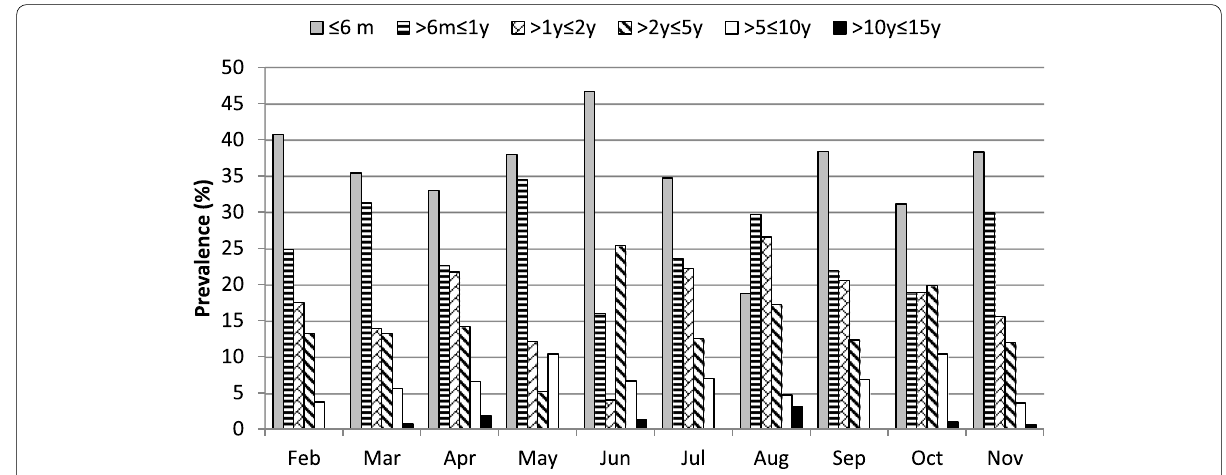
Fig. 1 Monthly percentage prevalence of lower respiratory tract infections (LRTIs) in children in the District Bannu in